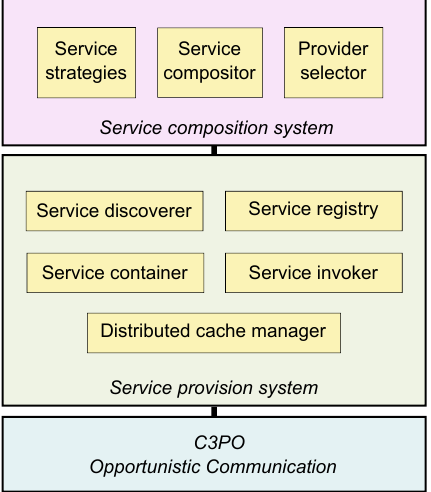
Figure 1. Overall architecture of the service-oriented middleware